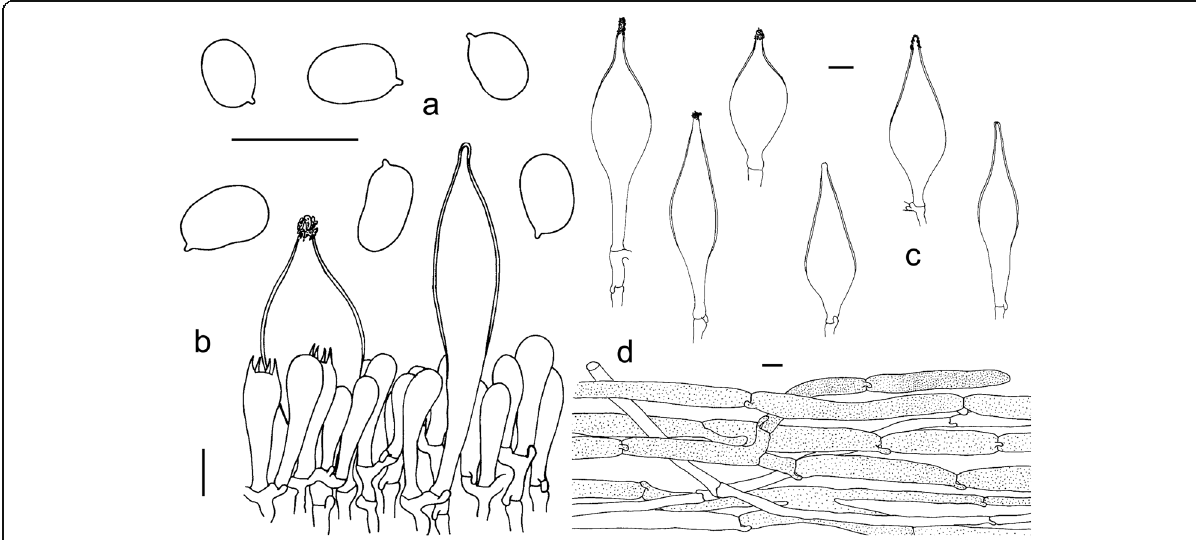
Fig. 9 Microscopic features of Squamanita orientalis (HKAS74862A, holotype). a Basidiospores. b Hymenium and subhymenium with one of the two pleurocystidia covered with refractive incrustations. c Pleurocystidia, four of them covered with refractive incrustations. d Pileipellis section. Drawings by Jianwei Liu. Bars = 10 μ